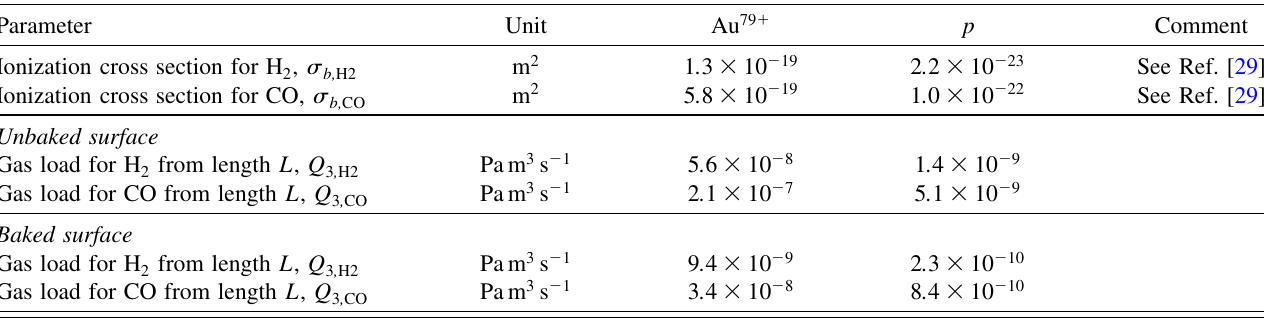
TABLE V. Estimate of gas load Q in the warm vacuum regions due to residual gas ionization by the beam, subsequent acceleration 3 of the ions by the beam, and ion-impact desorption. The dynamic pressure, ion-energy at the wall, and ion-impact desorption coefficients assumed here are the same as in Table